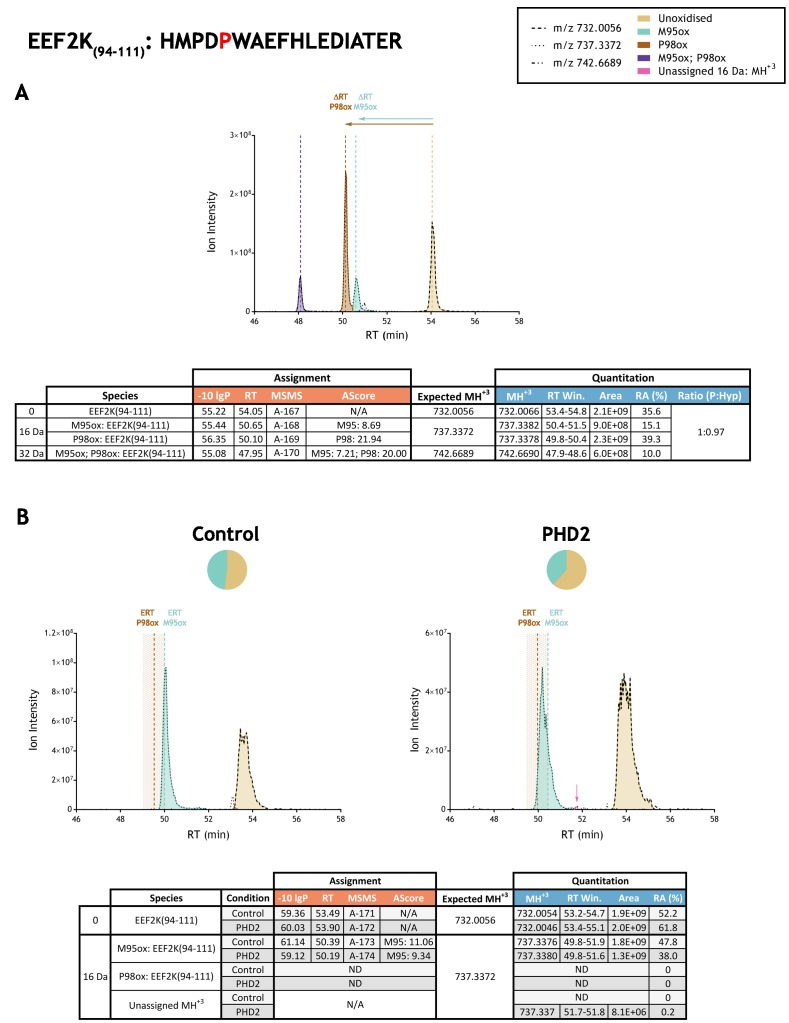
Quantitation of peptide oxidation on EEF2K(94-111) following reaction of full-length eukaryotic elongation factor 2 kinase with recombinant PHD2.XIC data presented in (A) shows ion intensity and retention time (RT) characteristics of equimolar synthetic peptide standards for unoxidised and P98ox forms of the EEF2K(94-111) peptide. MSMS assigned species are coloured (see inset) and include non-enzymatic methionine oxidation (M95ox; turquoise) which elutes close to the hydroxyproline-containing (P95ox; brown) ion. Vertical dashed lines define peak maxima used to derive ΔRT values for M95ox and P98ox. Panel (B) shows comparable XIC data for protease-digested IVTT substrate under control (left) or PHD2-reacted (right) conditions. Peaks corresponding to unoxidised and M95ox forms of EEF2K(94-111) were assigned by MSMS; P98ox was not detected. Estimated RT (ERT) values for oxidised peptides, derived from (A), are indicated by dashed vertical lines; shading applied to ERT P98ox corresponds to a 1 min RT window that partially overlaps with the elution profile of M95ox. Note, follow-up studies that employed parallel reaction monitoring of MS2 ions found no evidence for P98ox co-eluting with M95ox in IVTT-derived material (Figure 3). Peptide ions of low abundance that were compatible with oxidation but not assigned by MSMS are indicated (pink arrow). Quantitative data for observed species are presented as pie charts with XIC data. Assignment and quantitation data are tabulated below each panel, table headers are as follows: (−10lgP) significance score of leading assignment at given (RT) with ambiguity score (AScore) for PTM localisation and reference to primary MSMS data in Supplementary file 1. Quantitative data reports ion counts (Area) of observed masses (MH+3) integrated over time (RT Win.), expressed as relative abundance (RA). Data on detection efficiency for synthetic peptides (Panel A, P: Hyp) is an aggregated ratio of prolyl (P) to hydroxyprolyl (Hyp) containing species.